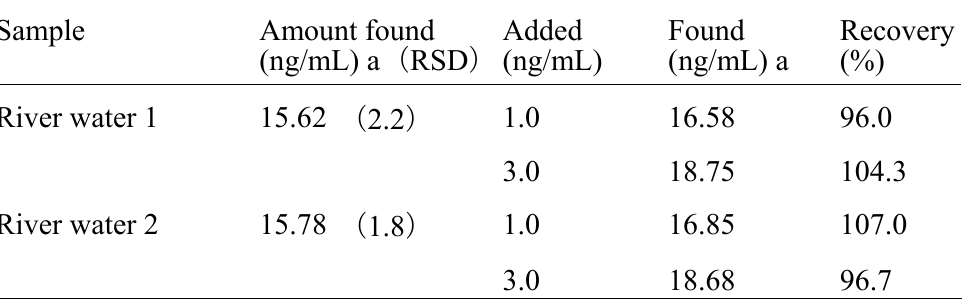
Table 1. Determination of Catechol in River Water